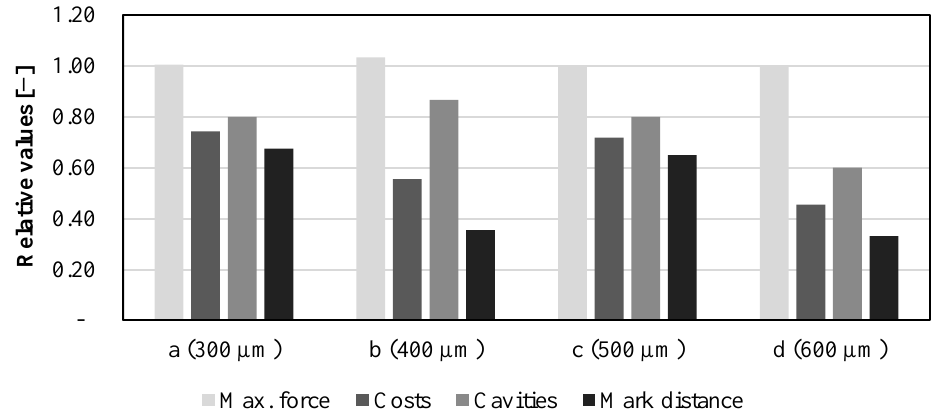
Figure 15. Results of the optimization approach. The relative values are given in comparison to the respective benchmarks (see Table 2).